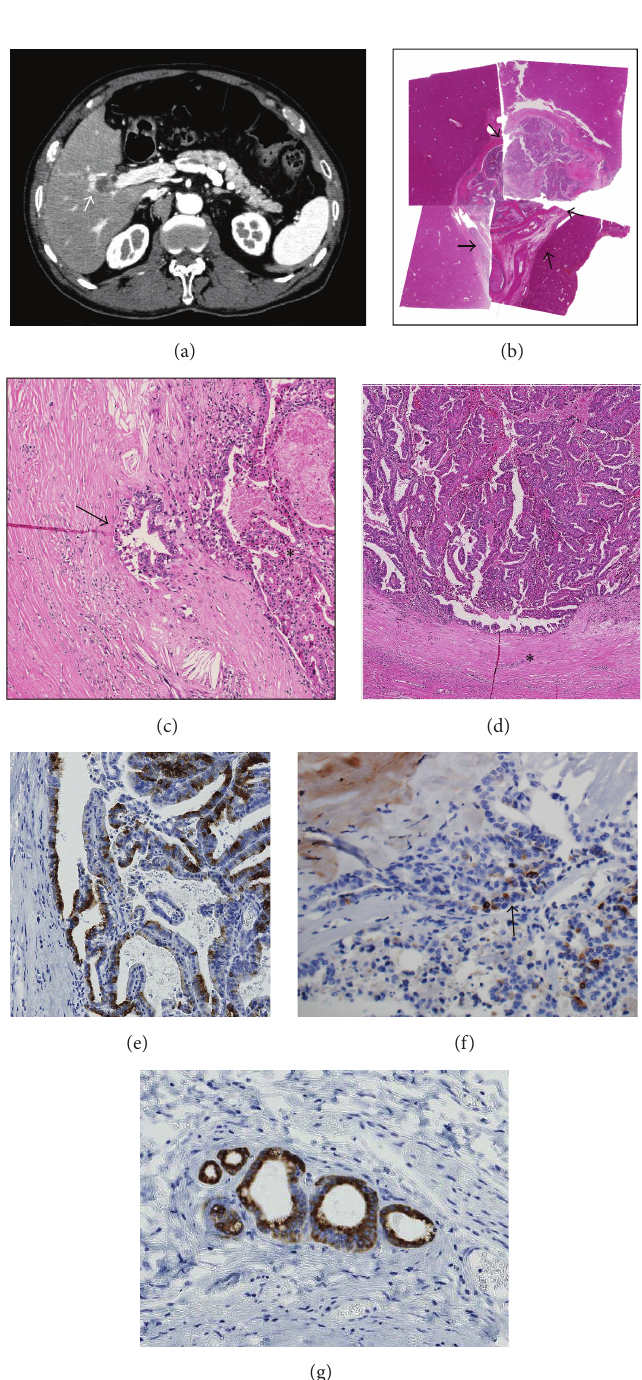
Figure 1: Case 1 . (a) Contrast-enhanced CT shows a cystic lesion (arrow) (20mm in diameter) at the confluence of the anterior and right bile duct with ring enhancement. There is no dilatation of the intrahepatic bile duct, except for slight dilatation of the proximal branches of the anterior branch of the bile duct. (b) The tumor (20 × 17 mm) is cystic and is filled with neoplastic cells and surrounded by a fibrous cyst wall (arrows). Loupe picture of the tumor (H&E staining). (c) Focal invasion of carcinoma is found in the fibrous capsule (arrow). Original magnification, 100x; H&E staining. (d) A papillary neoplasm composed of high-grade dysplasia with fine fibrovascular cores fills the cystic space of the tumor. ∗ Fibrous capsule. Original magnification, 30x; H&E staining. (e) The papillary neoplasm is positive for MUC6. Original magnification, 100x; immunostaining for MUC6. (f) The invasive carcinoma in the fibrous capsule is positive for MUC6 (arrow). Original magnification, 100x; immunostaining for MUC6. (g) The peribiliary glands (nonneoplastic) adjacent to the tumor are also positive for MUC6. Original magnification, 100x; immunostaining for